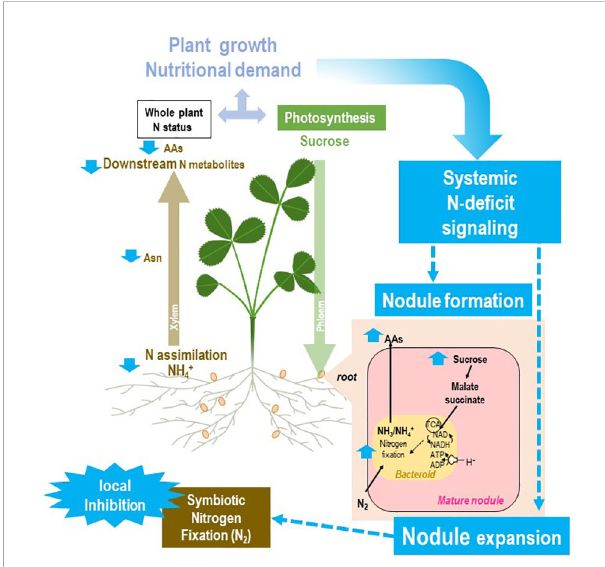
FIGURE 5 Systemic responses of the rhizobium – legume holobiont to plant N de fi cit. The general framework of the fi gure is described in Figure 2. Split-root systems used to characterize N-demand signaling are described in Figure 3. Various steps of the regulatory loop are indicated in blue. A local suppression of SNF may be obtained arti fi cially (by replacing locally air by a mixture Ar/O 2 80/20 v/v) or as the result of abiotic stresses. The local inhibition of symbiosis in the roots exposed to these conditions results in a partial decrease of the whole plant SNF. As the whole plant N demand is not fully satis fi ed, the systemic signaling promoting symbiosis is activated, resulting in the formation of new nodules on the other roots not exposed to the constraint. In mature nodules of these roots, the N- de fi cit systemic signaling results in a strong increase in nodule sucrose and organic acid levels associated with nodule expansion. This increase in nodule biomass is associated with higher levels of SNF in roots not exposed to the local constraint that may compensate the plant N de fi